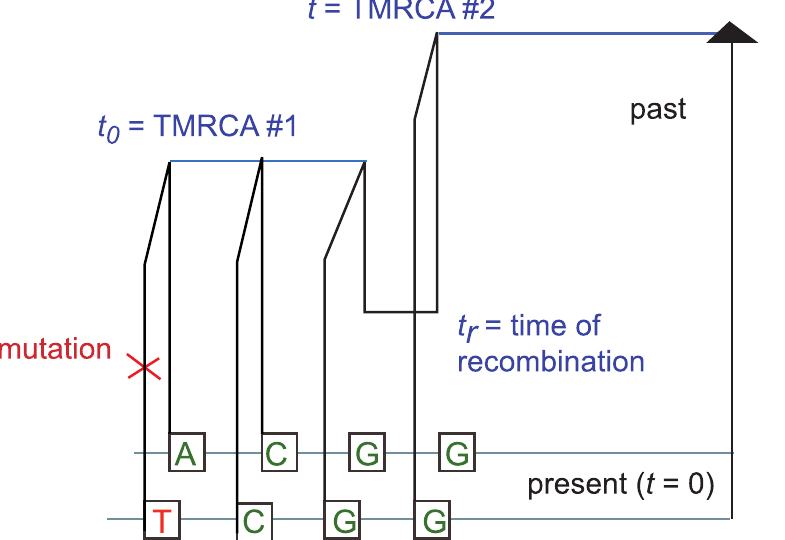
Figure 9. The coalescent with recombination and the sequentially Markov coalescent associate an observed pair of DNA sequences with a history that specifies a time to most recent common ancestry for each base pair. Polymorphisms are caused by mutation events, while changes in TMRCA are caused by recombination events.